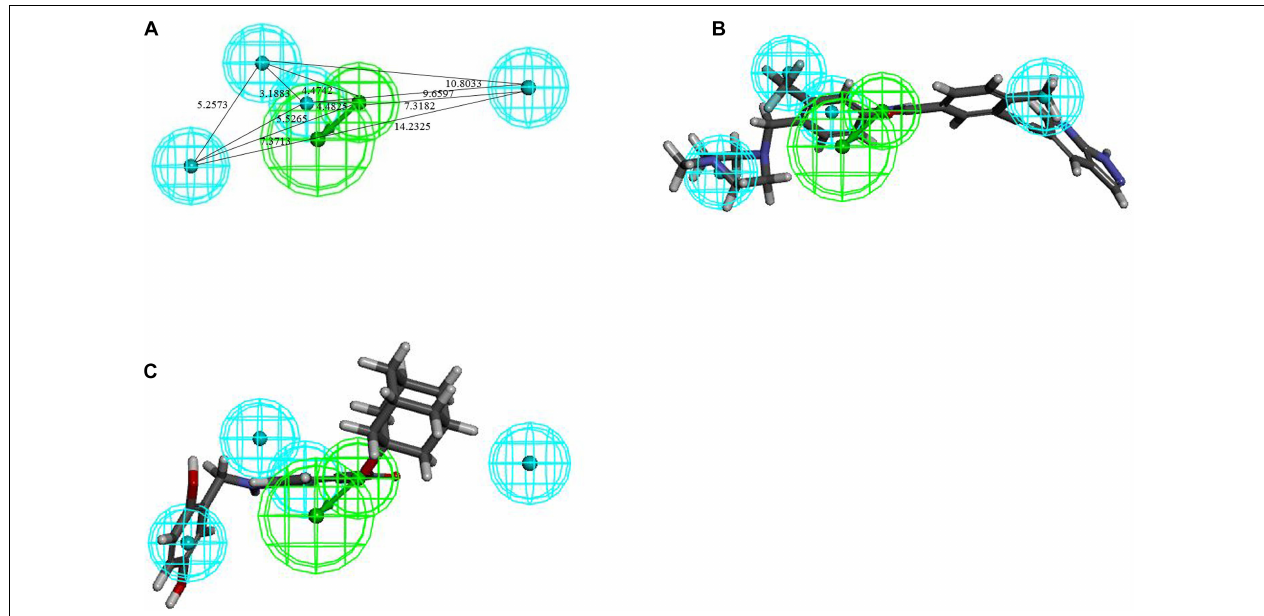
FIGURE 2 | (A) 3D spatial relationship and geometric parameters of Hypogen1. (B) Hypogen1 mapping with the most active compound. (C) Hypogen 1 mapping with the least active compound.